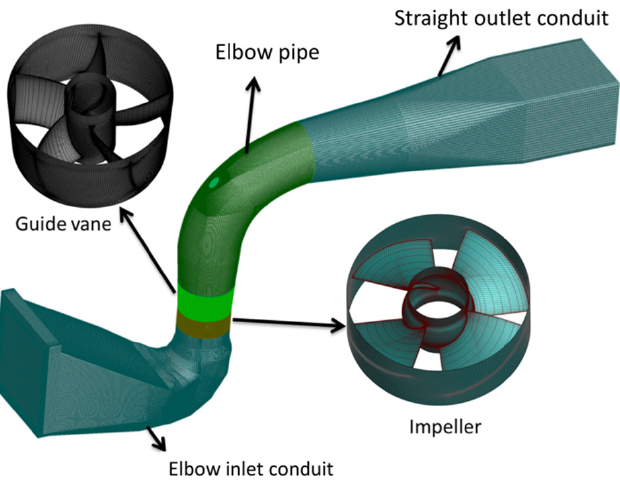
Figure 4. Grid diagram of flow passage components of the vertical axial-flow pump device. Table 1. Effect of grid number on pump device efficiency.